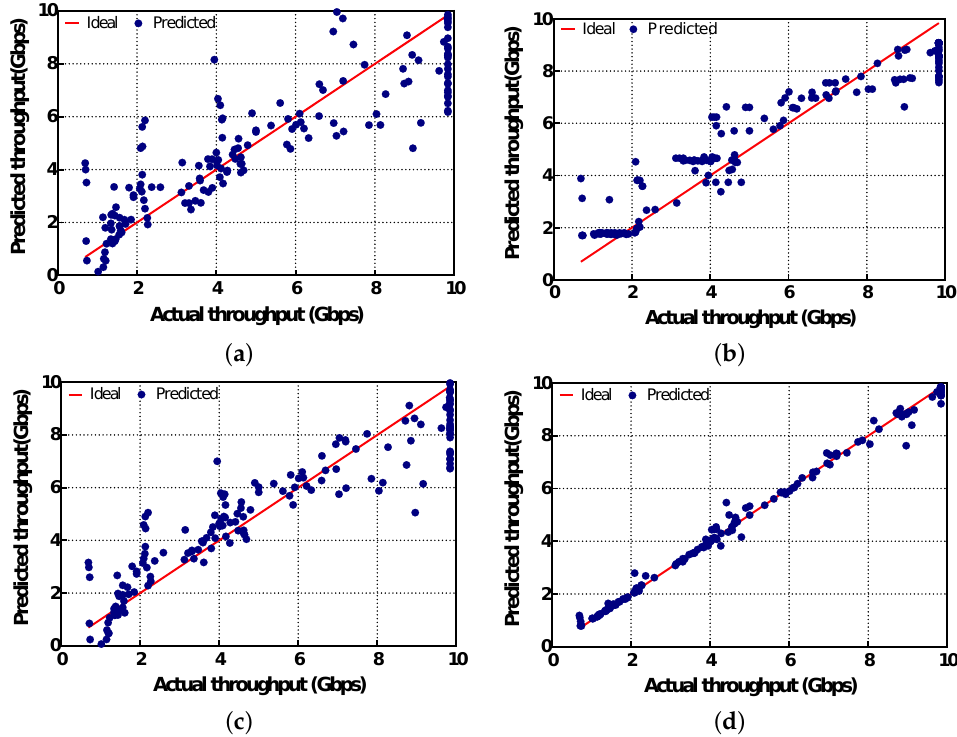
Figure 2. Test data results that show the actual value on x-axis and the predicted value (on the y-axis) using ( a ) LR, ( b ) ABR, ( c ) KRR, and ( d )